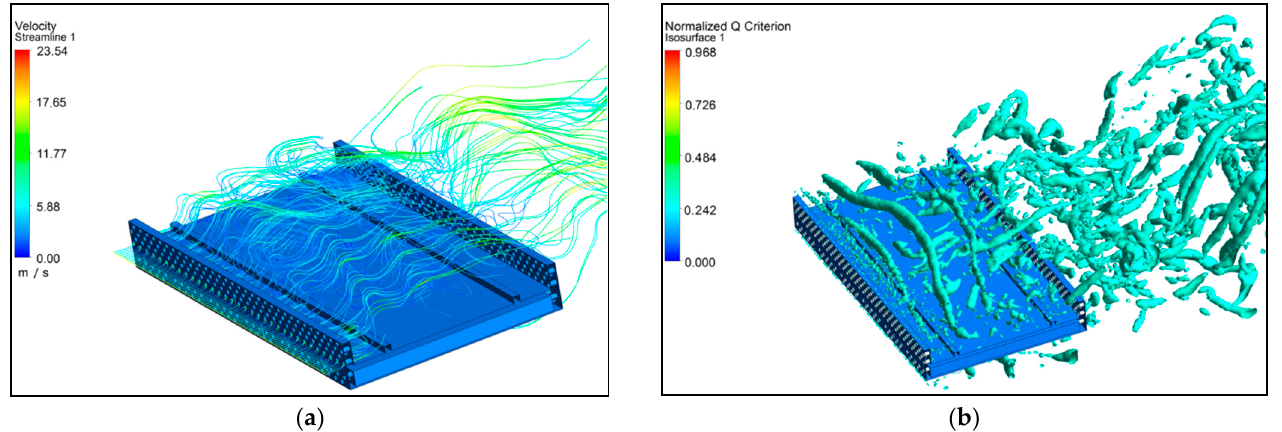
Figure 8. The results of numerical calculations of the flow around the model No. 2 with permeable walls: ( a ) Picture of current lines in the near model; ( b ) Isosurface of the Q-criterion near model. The result of spectral analysis of lift pulsations for the zero angle of attack for both models in numerical environment is shown in Figure 9. The dominant frequency f a = 25.7 Hz was revealed for both models of girders (with solid walls and permeable). This fre- quency corresponds to the Struhal number Sh = 0.112.